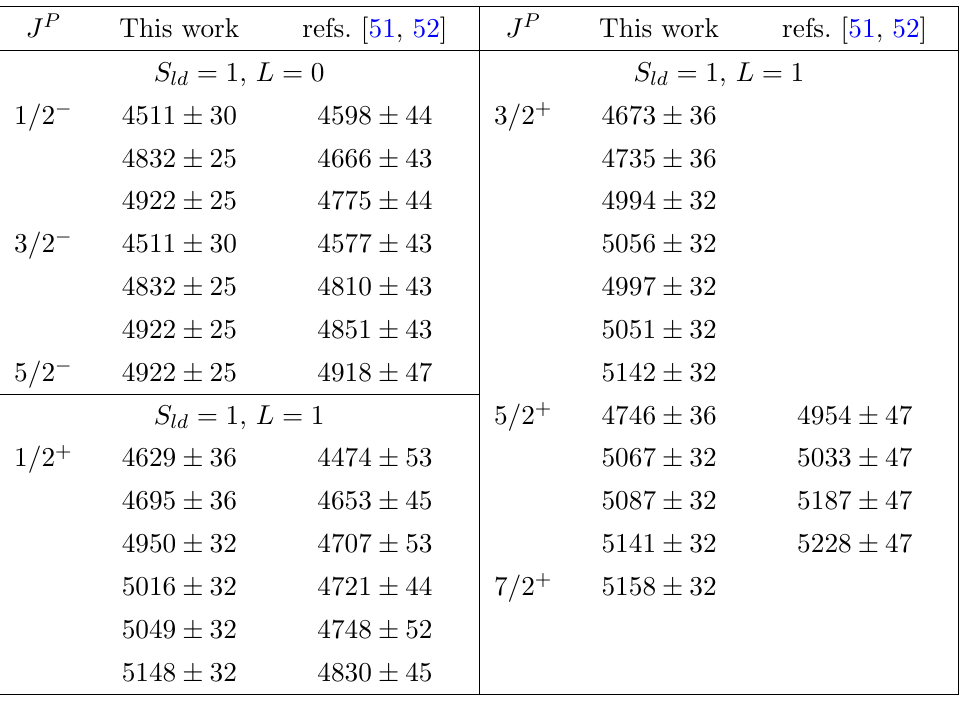
Table 13 . Masses of the hidden-charm doubly-strange pentaquarks (in MeV) with the doubly- strange light diquark, i.e. having the structure ((cid:22) c (cid:22)3 [ cq ] (cid:22)3 f ss g (cid:22)3 ), where q is u - or d -quark and curly brackets denote the spin-1 light diquark, and their comparison with the results presented in [51, 52]. For the P -wave pentaquarks, the values of the orbital, spin-orbit and tensor couplings are taken from table